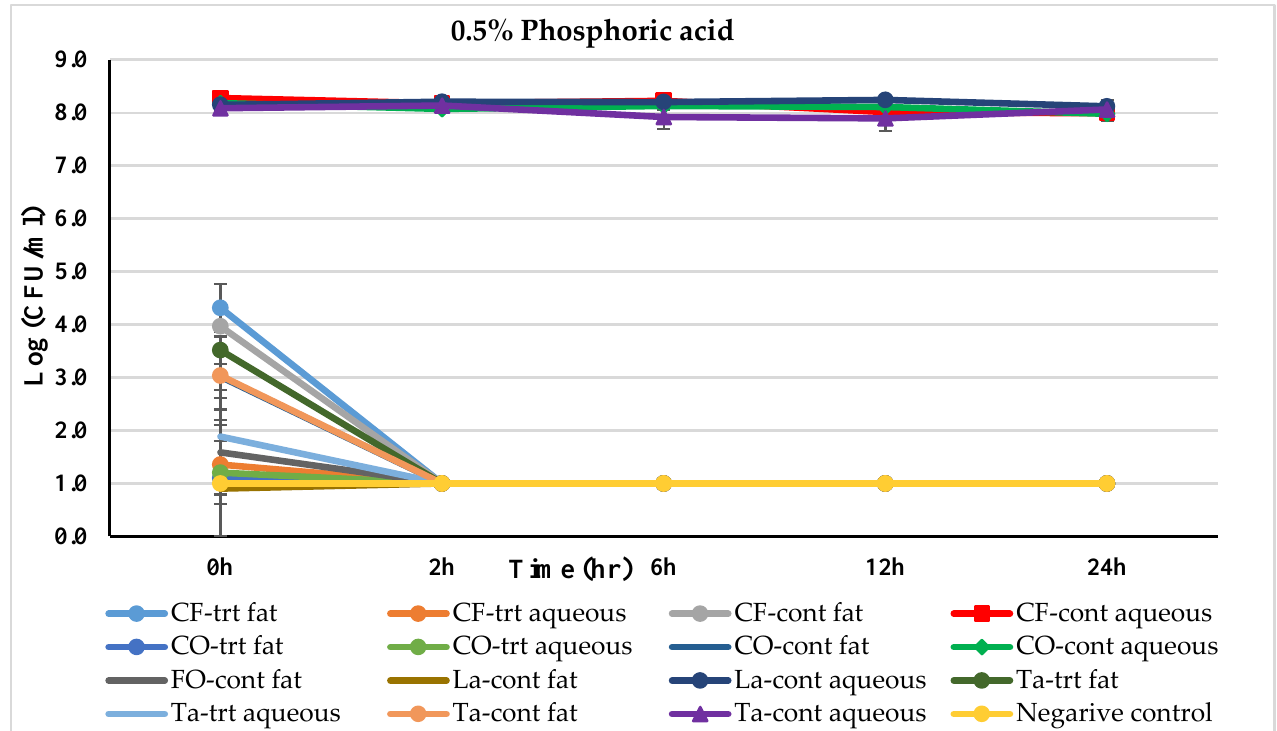
6 of 14 Figure 1. Mean logarithmic counts (log CFU/mL) of Salmonella spp. in different fat and oil systems with and without the inclusion of 0.5% sodium bisulfate evaluated separately for the aqueous phase and fat phase at 45 °C. Treatments from each phase were plated on TSA at different times. SBS, sodium bisulfate; CF, chicken fat; CO, canola oil; La, Lard; Ta, Tallow; Cont., control. Negative con-